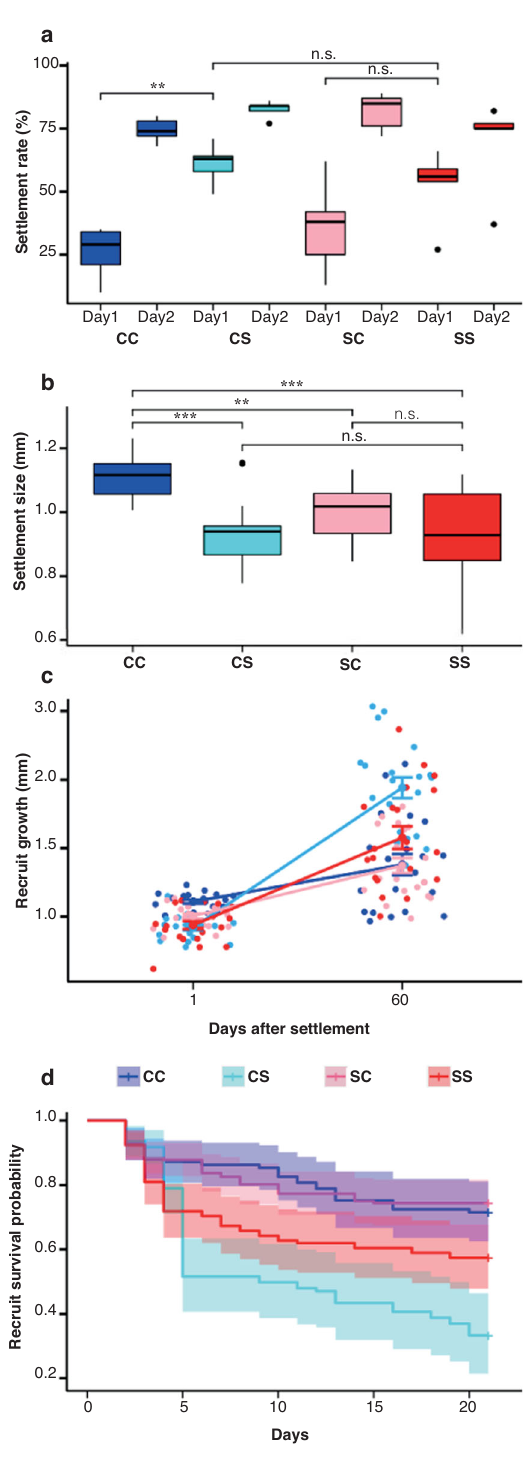
Fig. 4 Effect of thermal stress on the larval settlement rates and size (Experiment 3), and the recruit growth and survival rates (Experiment 4) of Acropora tenuis . a Effect of thermal stress on larval settlement rates in control (CC and CS) and thermal stress (SC and SS) treatment groups. Settlement rates are shown after 24 h (1 day) and 48 h (2 days) under high (~31 °C) and control (~28 °C) temperatures ( n = 100 larvae per treatment) after 24 and 48 h from the beginning of the experiment. Each box indicates CC (Dark blue), CS (cyan), SC (pink), and SS (red). b Settlement size (mm) in each treatment group. The largest diameter of the recruits was measured